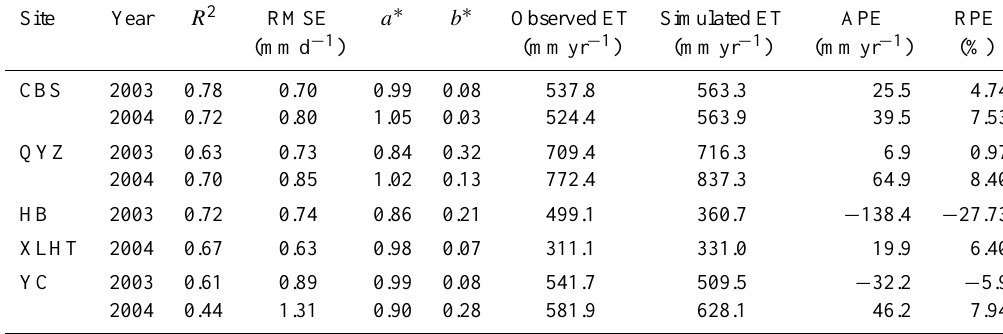
Table 3. Statistics of simulated and observed daily and annual ET at the five flux tower sites.